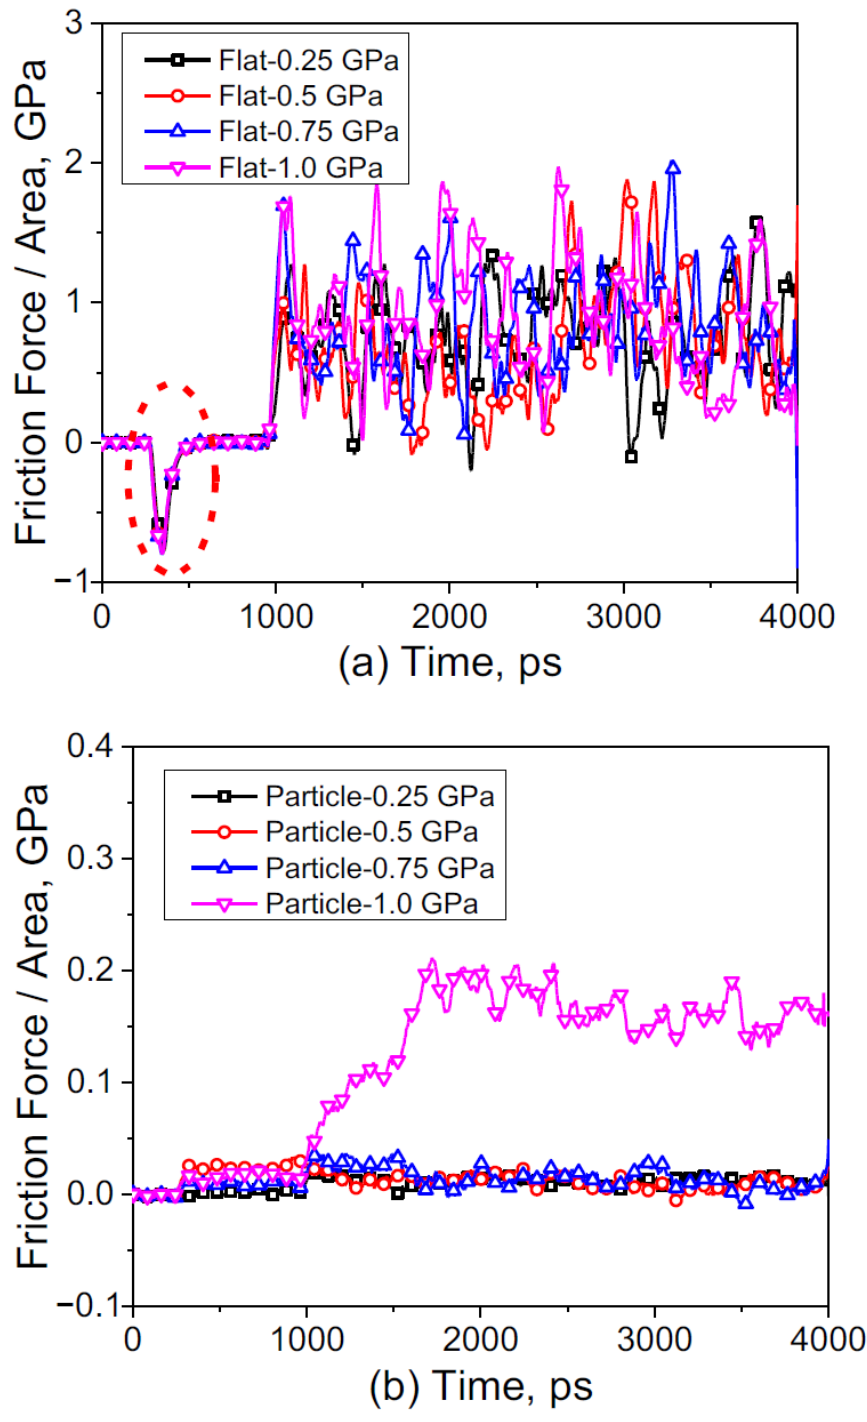
Figure 4. The friction force evolution history when normal load is increased from 0.25 to 1.0 GPa in the ( a ) flat and ( b ) particle models.